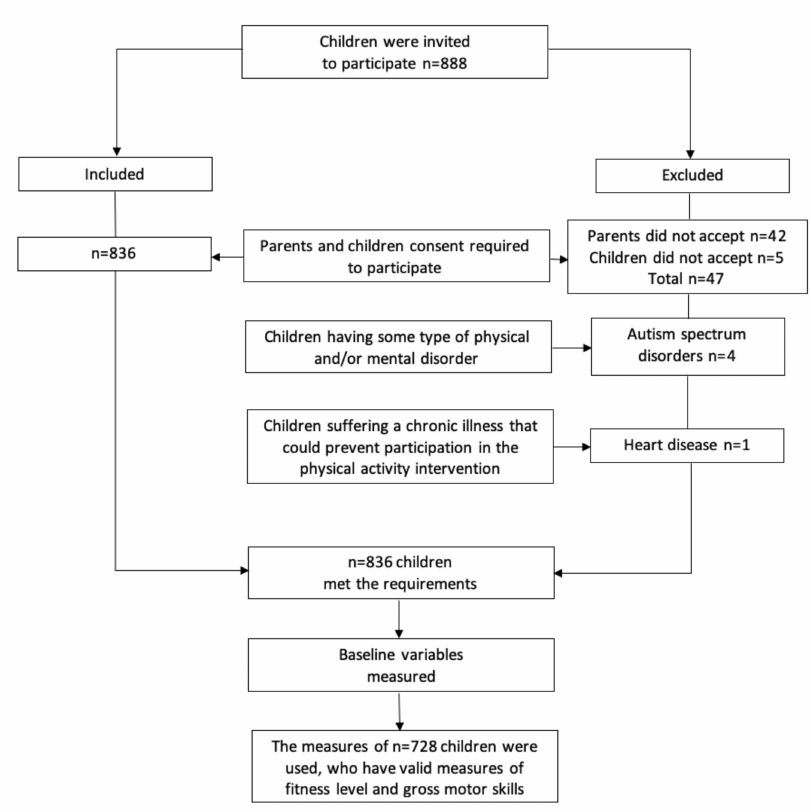
Figure 1. Flow diagram of participant recruitment and exclusion with